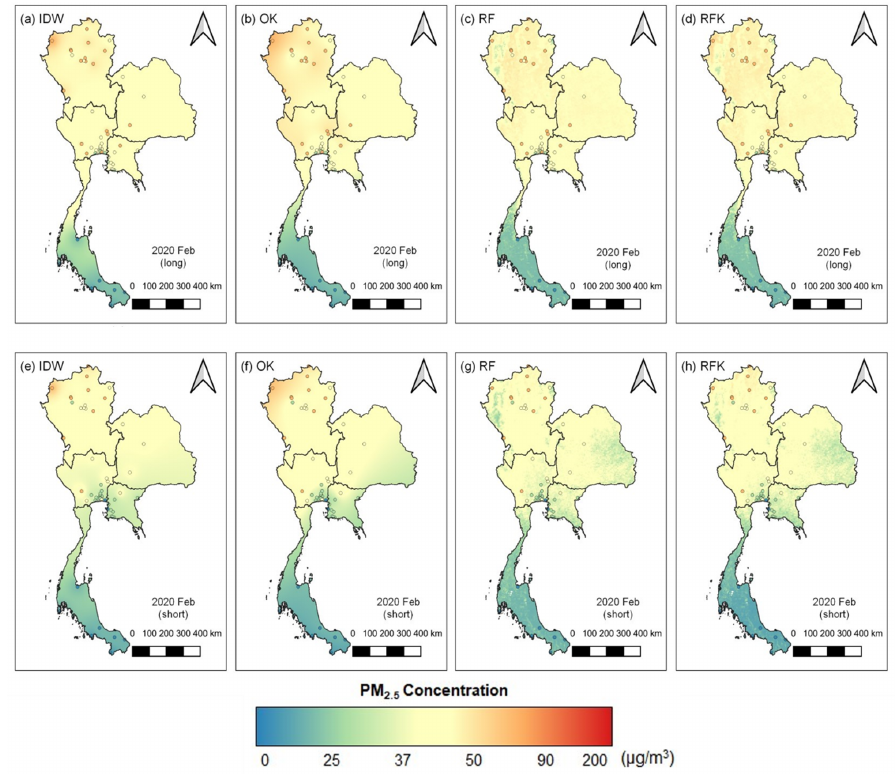
Figure 4. Interpolated PM 2.5 concentrations from different spatial interpolation methods ( a – d ) from 1 to 9 February and ( e – h ) from 8 to 18 February.